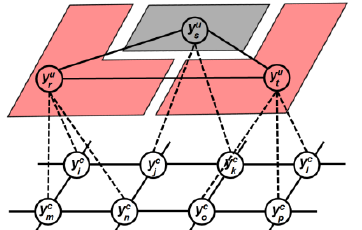
Figure 1: Graphical model consisting of two layers, land cover layer (c) and land use layer (u). Nodes are depicted as circles, intra-layer edges as solid and inter-layer edges as dashed lines.